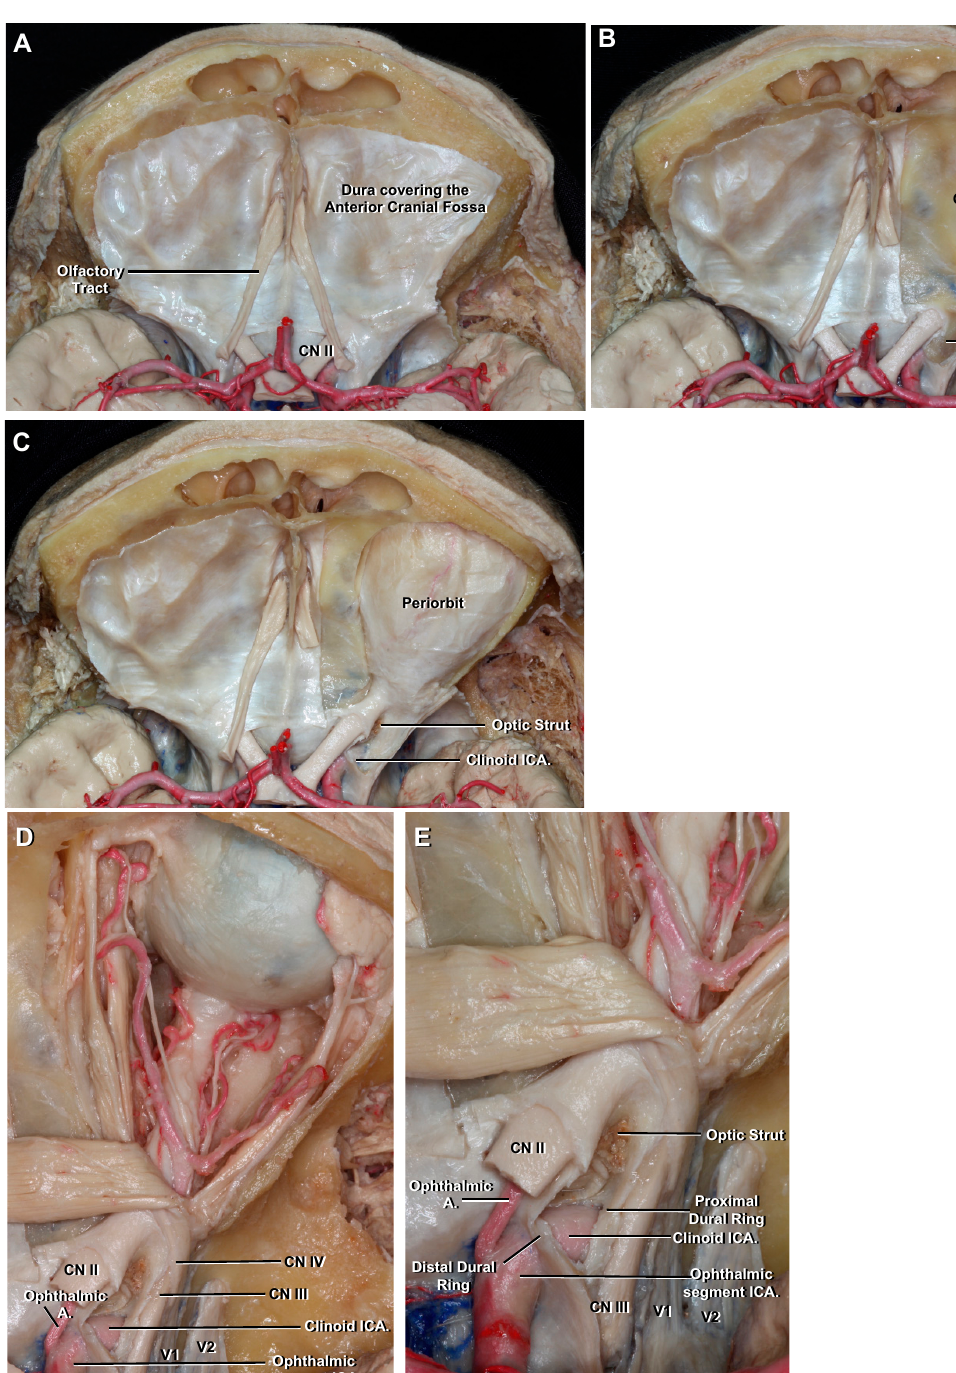
Figure 3. ( A ) Anterior cranial fossa, superior view. The dura is seen covering both orbital roofs. ( B ) The dura covering the right orbital roof has been removed to show the anterior clinoid process. The supraclinoid ICA enters the subarachnoid space medial to the anterior clinoid process and follows a posterior and slightly superior trajectory. ( C ) The roof of the right orbit has been removed to expose the periorbit. The right anterior clinoid process has been removed to expose the clinoid ICA. ( D ) The periorbit and orbital fat has been removed. The ophthalmic artery originates from the superomedial surface of the supraclinoid ICA, below the optic nerve, and then runs anteriorly to enter the optic canal. At the orbital apex, it lies inferolateral to the optic nerve and then continues forward, crossing above it with an anteromedial trajectory. ( E ) Enlarged view. The clinoid ICA is the shortest of all ICA segments and is located between the proximal and distal dural rings. The optic canal and superior orbital fissure have been unroofed and the optic strut is identified separating them.